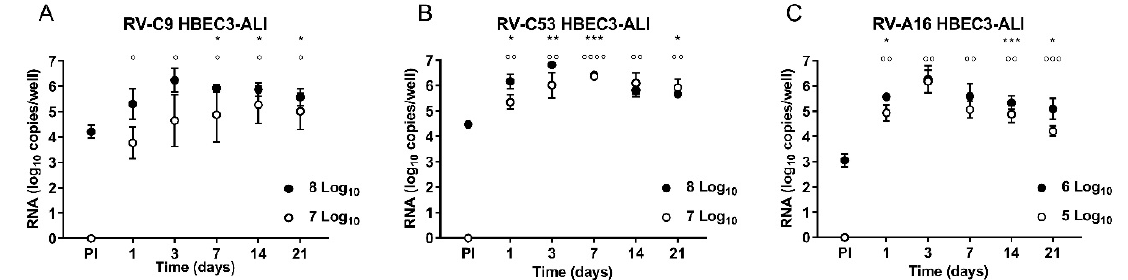
Figure 2. Growth properties of rhinoviruses (RVs) in HBEC3 air–liquid-interface (ALI) culture. For this, 8 or 6 (filled circles) and 7 or 5 (open circles) log 10 RNA copies/well of RV-C9 and -C53 or RV-A16, respectively, were inoculated onto HBEC3-ALI cultures (A, B and C). Data are expressed as log copies of RNA per well (n = 3) at 1, 3, 7, 14, and 21 day(s) after inoculation. PI represents the collected third wash solution. Differences in log RNA copies were analyzed by one-way ANOVA followed by Tukey’s multiple comparisons test. Asterisks (*) and circles (°) show differences between PI and each time point within 8 log 10 RNA copies/well of RV-Cs/6 log 10 RNA copies/well of RV-A inoculated groups and within 7 log 10 RNA copies/well of RV-Cs/5 log 10 RNA copies/well of RV-A inoculated groups. */° p < 0.05, **/°° p < 0.01, ***/ °°° p < 0.001, and ****/ °°°° p < 0.0001.